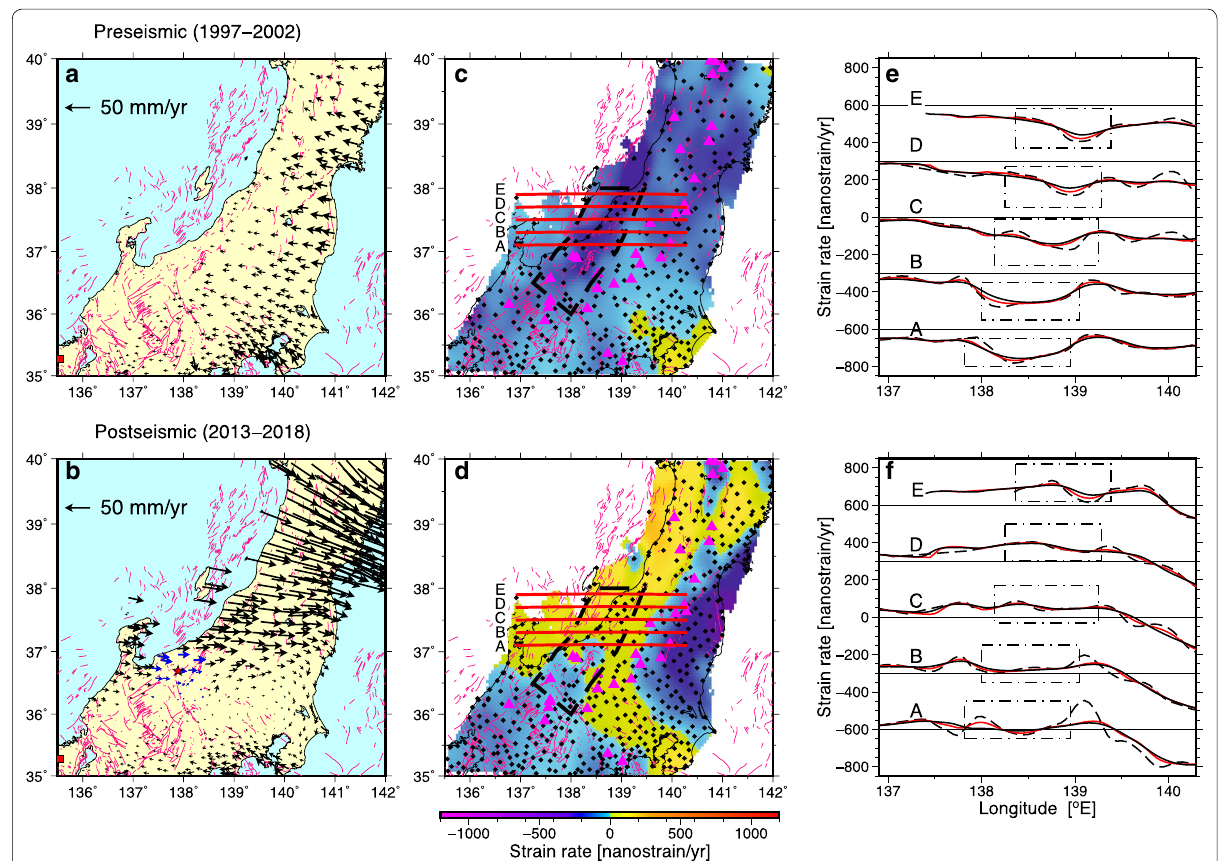
Fig. 1 Crustal deformation before (top panels) and after (bottom panels) the 2011 Tohoku‑oki earthquake. GNSS data from Jun 1997 to May 2002 and from Jun 2013 to May 2018 are used for the preseismic and postseismic periods, respectively. a , b Horizontal velocities with respect to the site 950262 (35.2759N, 135.5495E; red square) for each time period. Red lines represent active faults (Research Group for Active Faults of Japan 1991). In b coseismic correction of the 2014 northern Nagano earthquake (the epicenter is shown by the red star) is applied to GEONET stations shown by blue arrows. c , d E–W strain rate for each time period. In estimating the strain rate, the method of Shen et al. (1996) is used, where DDC is set at 25 km. The negative sign represents contraction. Thick red lines represent the locations of the strain‑rate profiles shown in e , f . The location of the northern NKTZ, enclosed by black dashed lines, follows Meneses‑Gutierrez and Sagiya (2016). Purple triangles and solid circles represent active volcanoes and GEONET stations, respectively. e , f E–W strain‑rate profiles from south (A: 37.1°N) to north (E: 37.9°N) in every 0.2°. Adjacent profiles are drawn with an offset of 300 nanostrain/year, where the zero level of the profile C corresponds to “0” in the scale of the vertical axis. Black solid, red solid, and black broken lines correspond to the DDC values of 30, 25, and 20 km, respectively. The location of each profile is shown in c , d . The extent of the northern NKTZ along each profile is shown by the dashed‑dotted